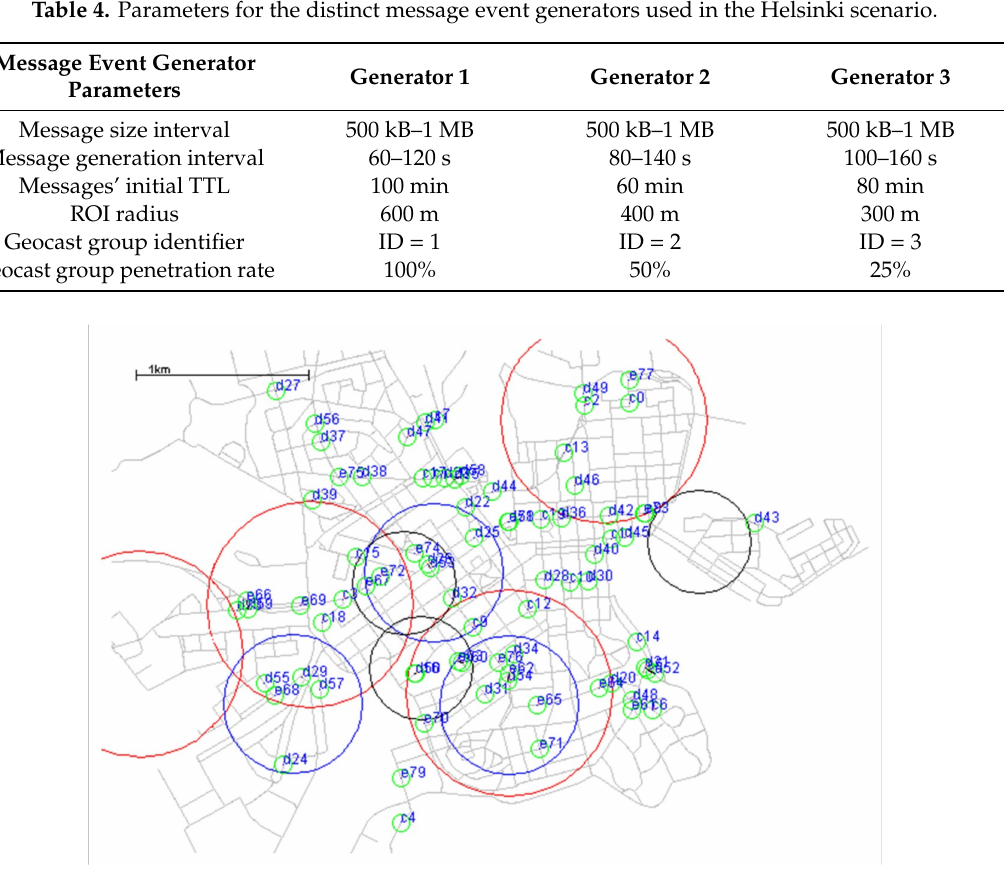
Figure 6. Simulation map of downtown Helsinki. The streets are marked gray. The map scale is shown at the top. Nodes are numbered in blue. Regions of interest marked with red, blue, and black for geocast groups one, two, and three. Green circles depict the nodes’ communication